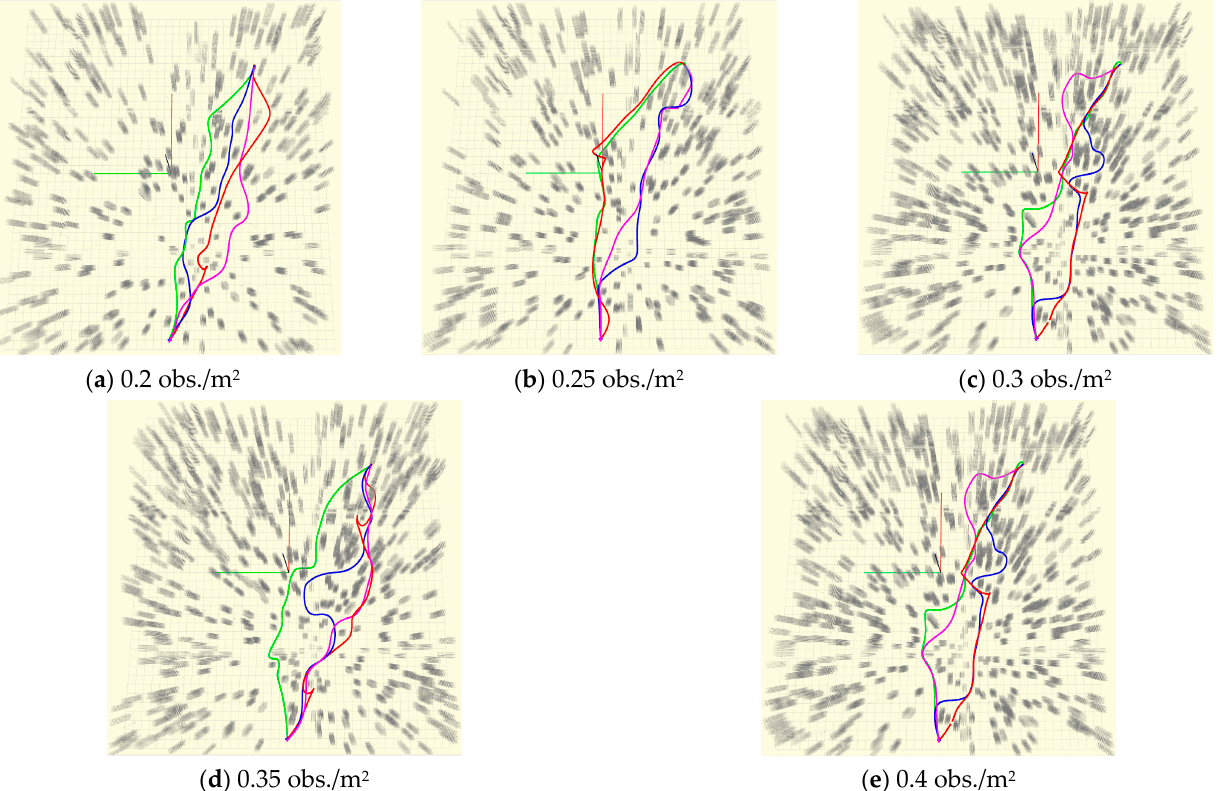
Figure 14. Trajectories generated by the proposed method (green), FASTER (pink), RET (red), and PGO (blue) in different obstacle densities.